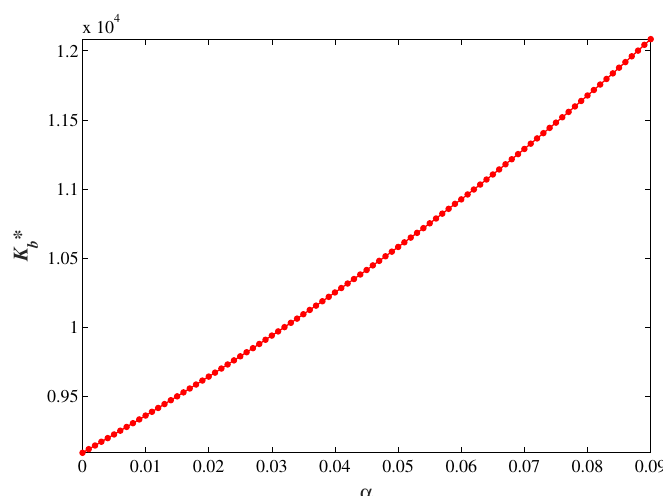
Figure 2. Optimal security investment allocation of each branch over the proportion of branch information